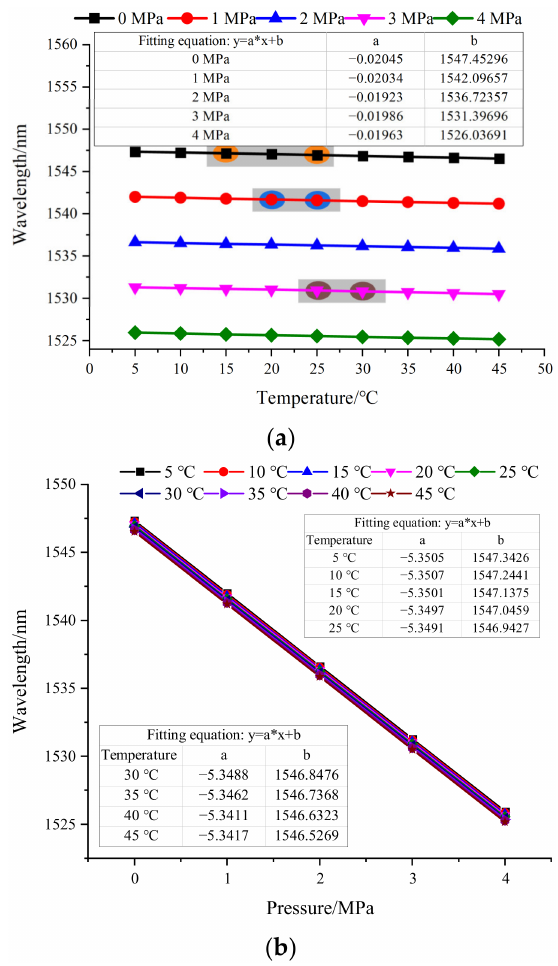
Figure 4. ( a ) Influence of temperature on wavelength under different pressure and ( b ) Influence of pressure on the wavelength at different